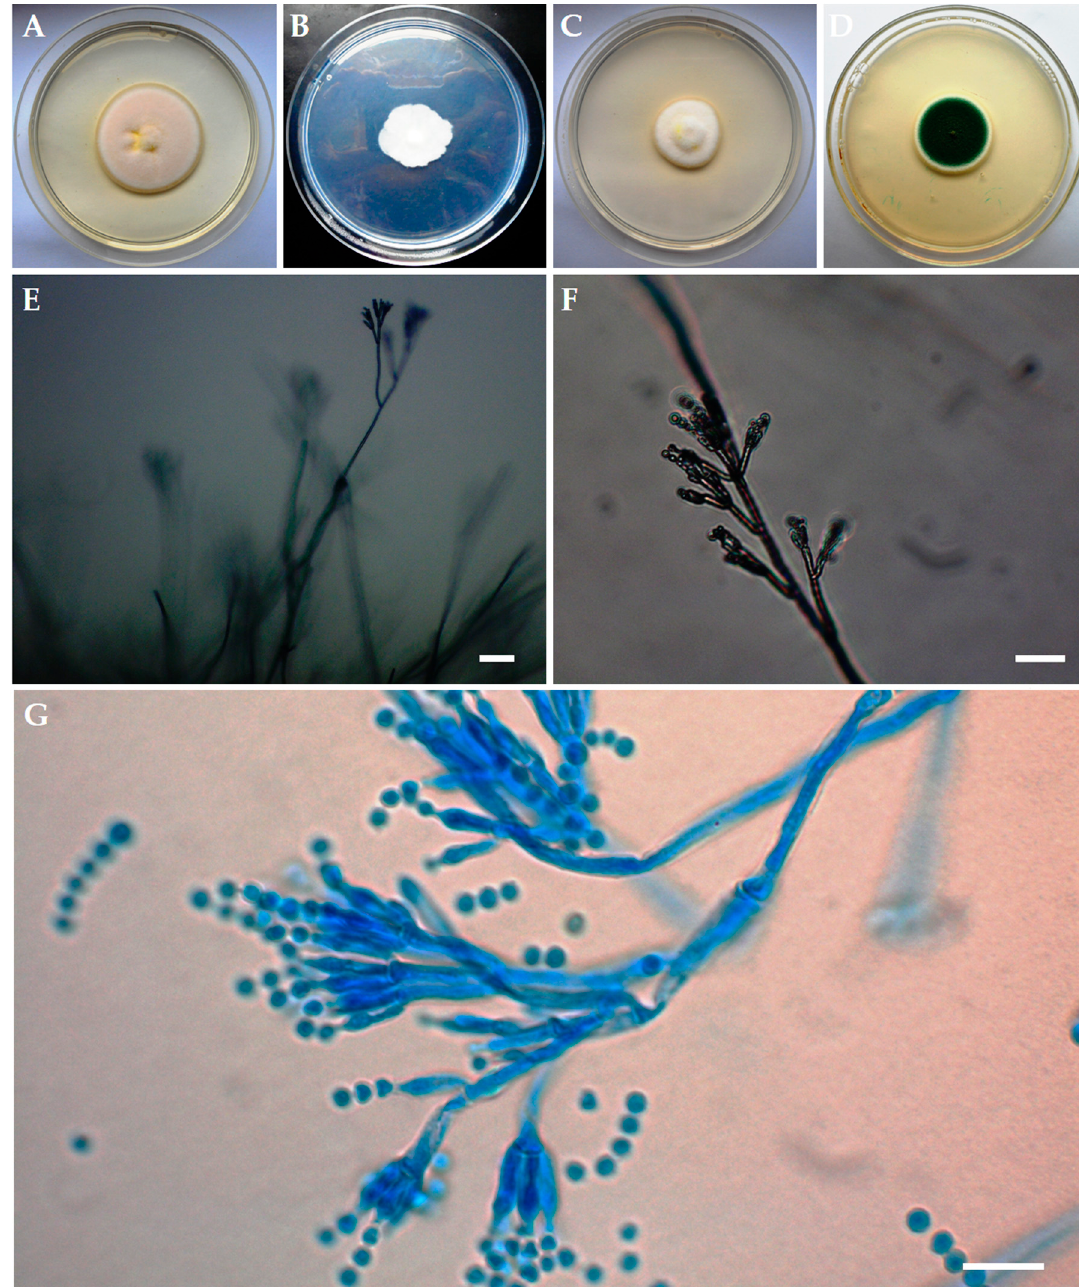
Figure 3. Macroscopic observations of 7-day-old Penicillium chrysogenum ( A ). CYA, ( B ). Czapek-Dox agar, ( C ). MEA, and ( D ). PDA and microscopic observations of morphological structures of 2-week-old P. chrysogenum ( E , F ). Petri dish cultures under the optical microscope with natural arrangement: stipe, branches, ramus, metulae, phialides, conidia, ( G ). Microscopic slide dyed with lactophenol cotton blue: rough branches, ramus and metulae, phialides, conidia) isolated most frequently from the wing membranes of female greater mouse-eared bats ( Myotis myotis ). The size of stipes ranged from 2.5–4 μ m, and of phialides ampuliform with a reduced neck from 7–10 to 2–2.5 μ m. Conidia were elliptical to subglobose, 3–4 in μ m long axis, and smooth. Scale bars: 50 μ m ( E ), 20 μ m ( F ), 10 μ m ( G , H ).